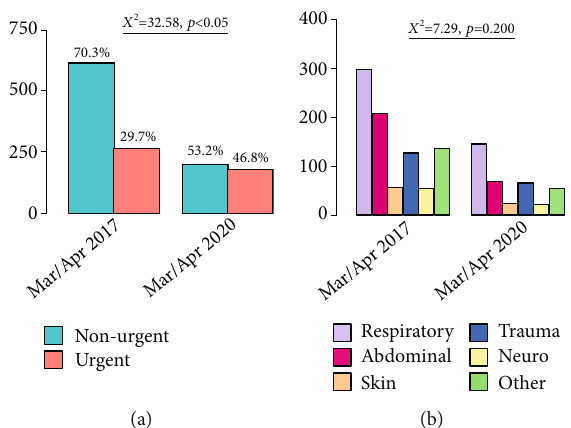
Figure 5: (a) Nonurgent and urgent visits to the pediatric ED and (b) preliminary diagnoses in March and April 2017, respectively, compared to March and April 2020 ( fi rst peak of COVID-19